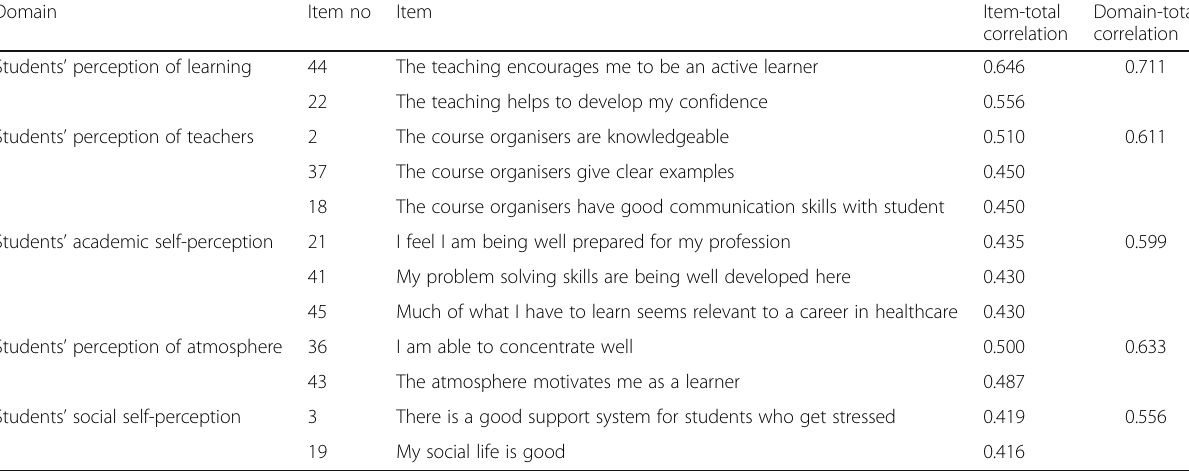
Table 2 Domain-wise list of items in DREEM-50 that had the highest item-total and domain-total correlations Domain Item no